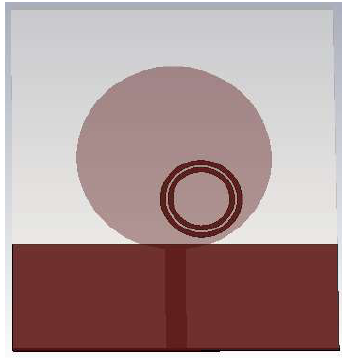
Figure 5: Patch with CRR loading.